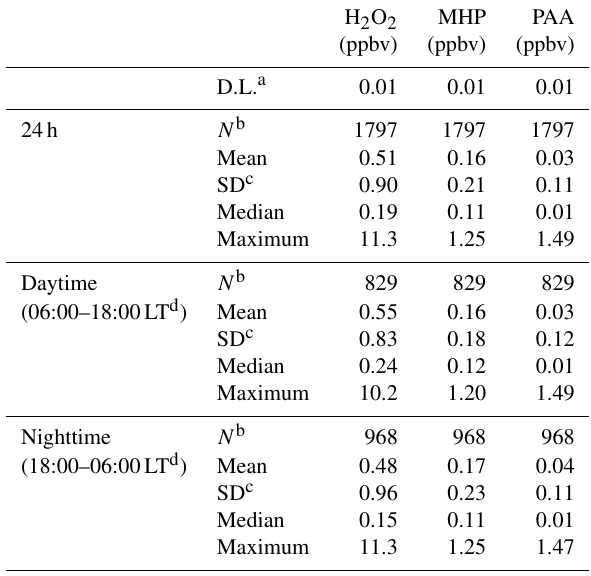
Table 1. Summary of the concentrations of atmospheric peroxides during Wangdu Campaign